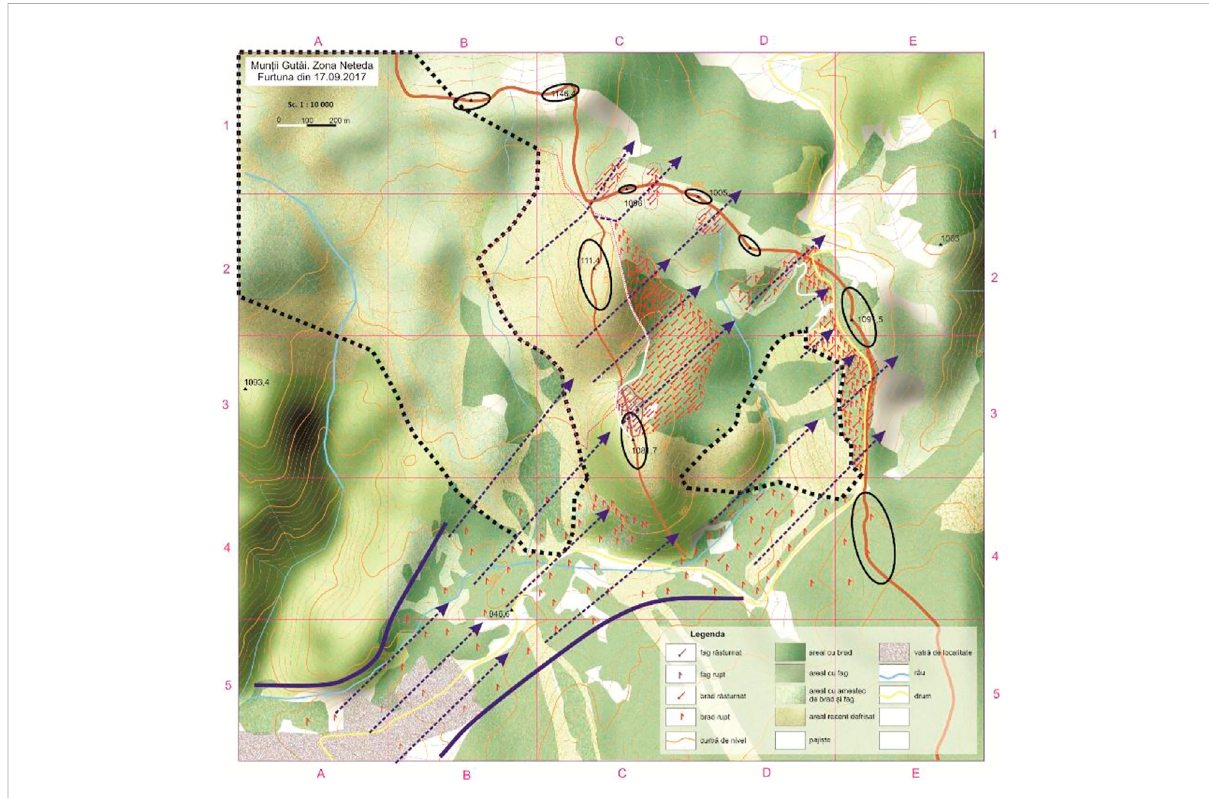
FIGURE 11 Gutai East area. Reconstructed windscape in QGIS treated with graphic design tools for the main